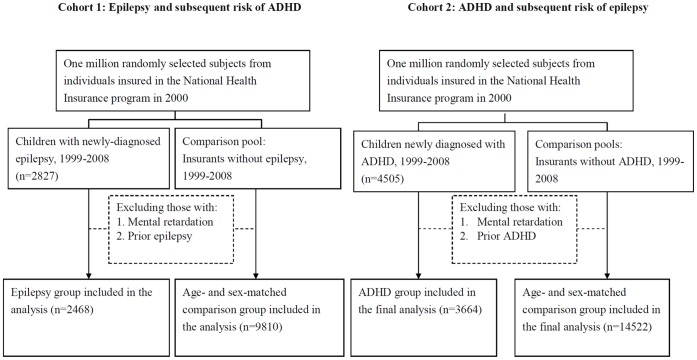
Schematic diagram of the selection of study subjects.